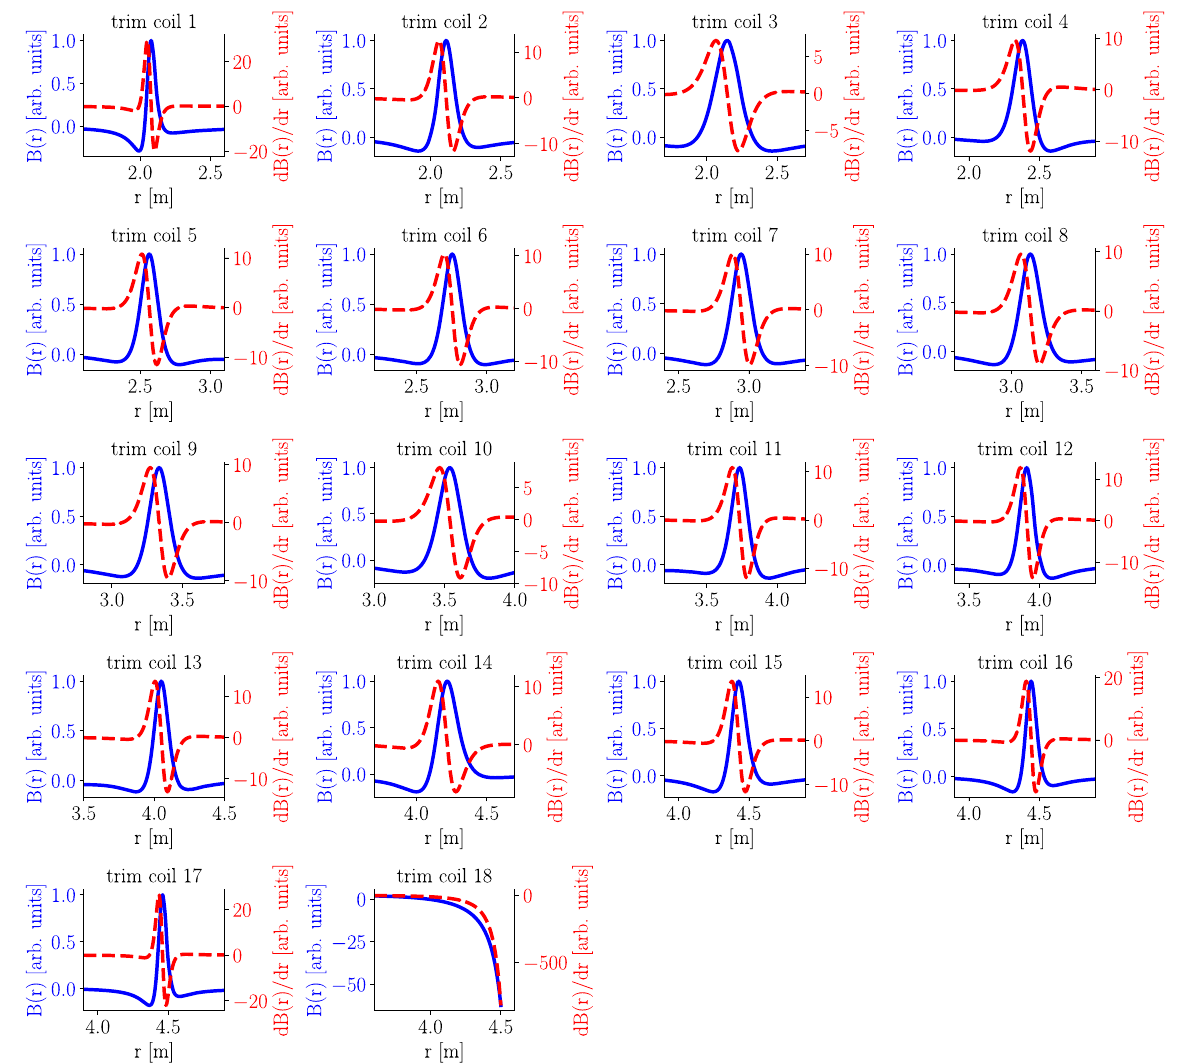
FIG. 10. Magnetic fields and their radial derivative of the trim coils.